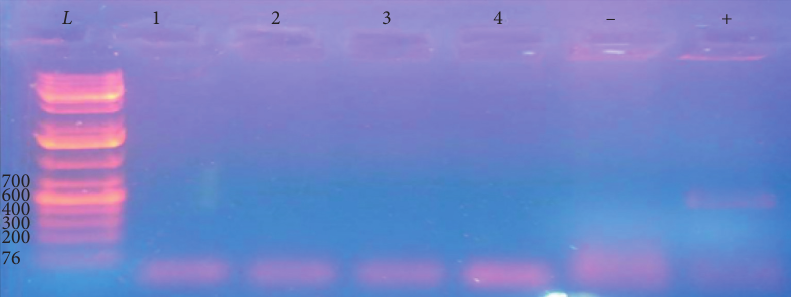
Figure 1: PCR amplification products of CABMV; 1, 2, 3, and 4 are the first four seedlings testing negative for CABMV. Negative control ( − ) is a sample from disease-free seedlings. Band size was compared with a 1kb ladder (L). The positive control (+) formed a band at 650bp, which is the expected size for CABMV. It was obtained from diseased plant maintained in a screen house. All the seedlings tested showed similar results.